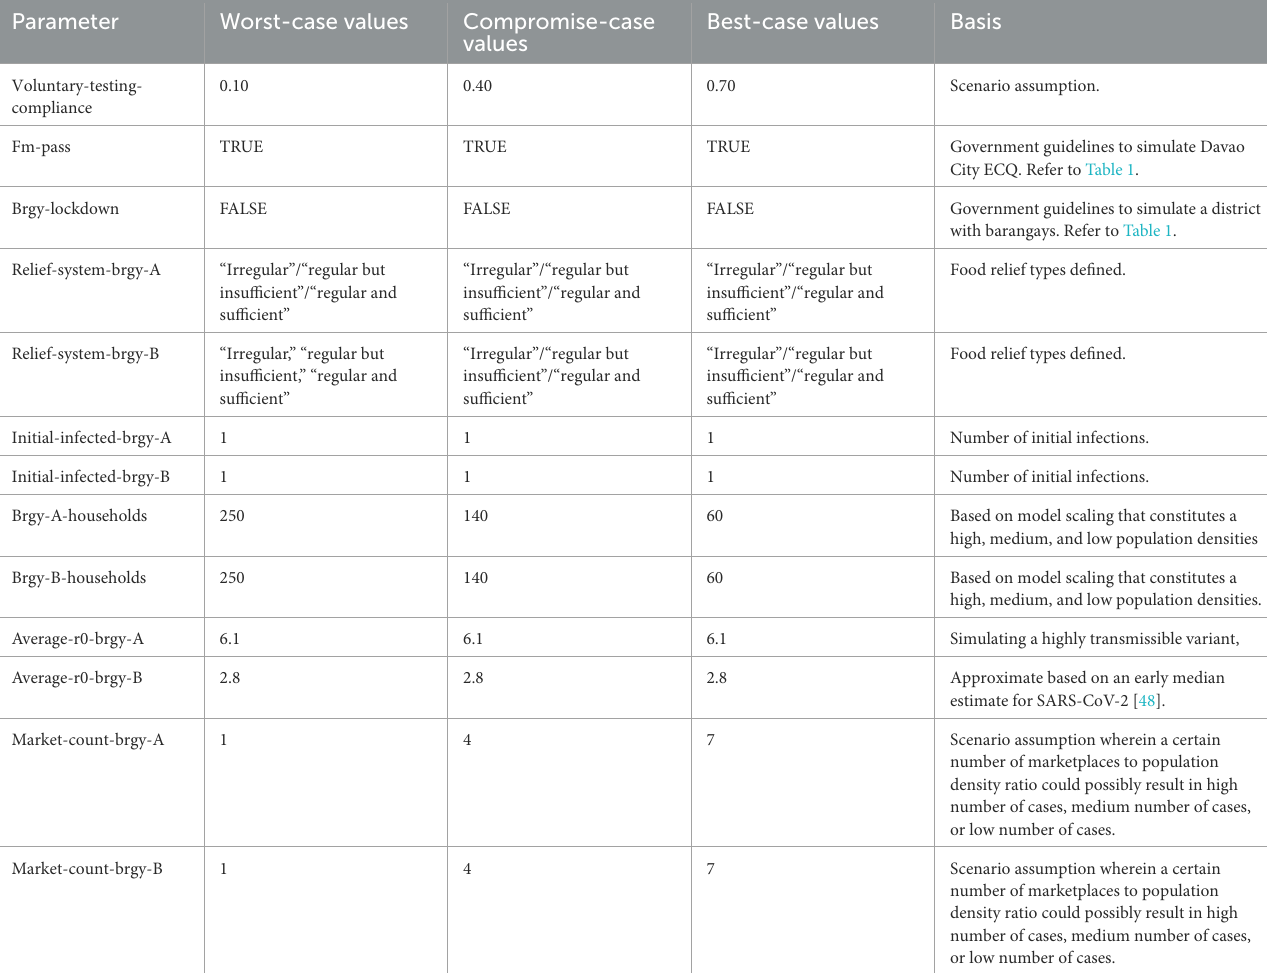
TABLE 6 Parameter values and settings set for every scenario’s simulation